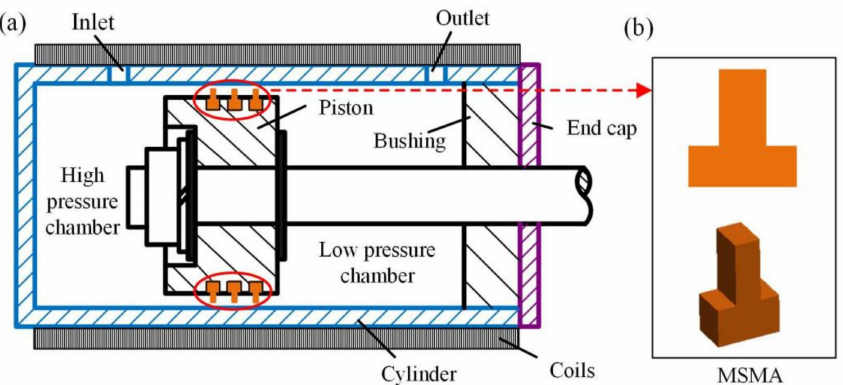
Figure 4. Clearance compensation of the hydraulic cylinder based on MSMA: ( a ) the structure design of gap compensation; ( b ) a single MSMA auxiliary support